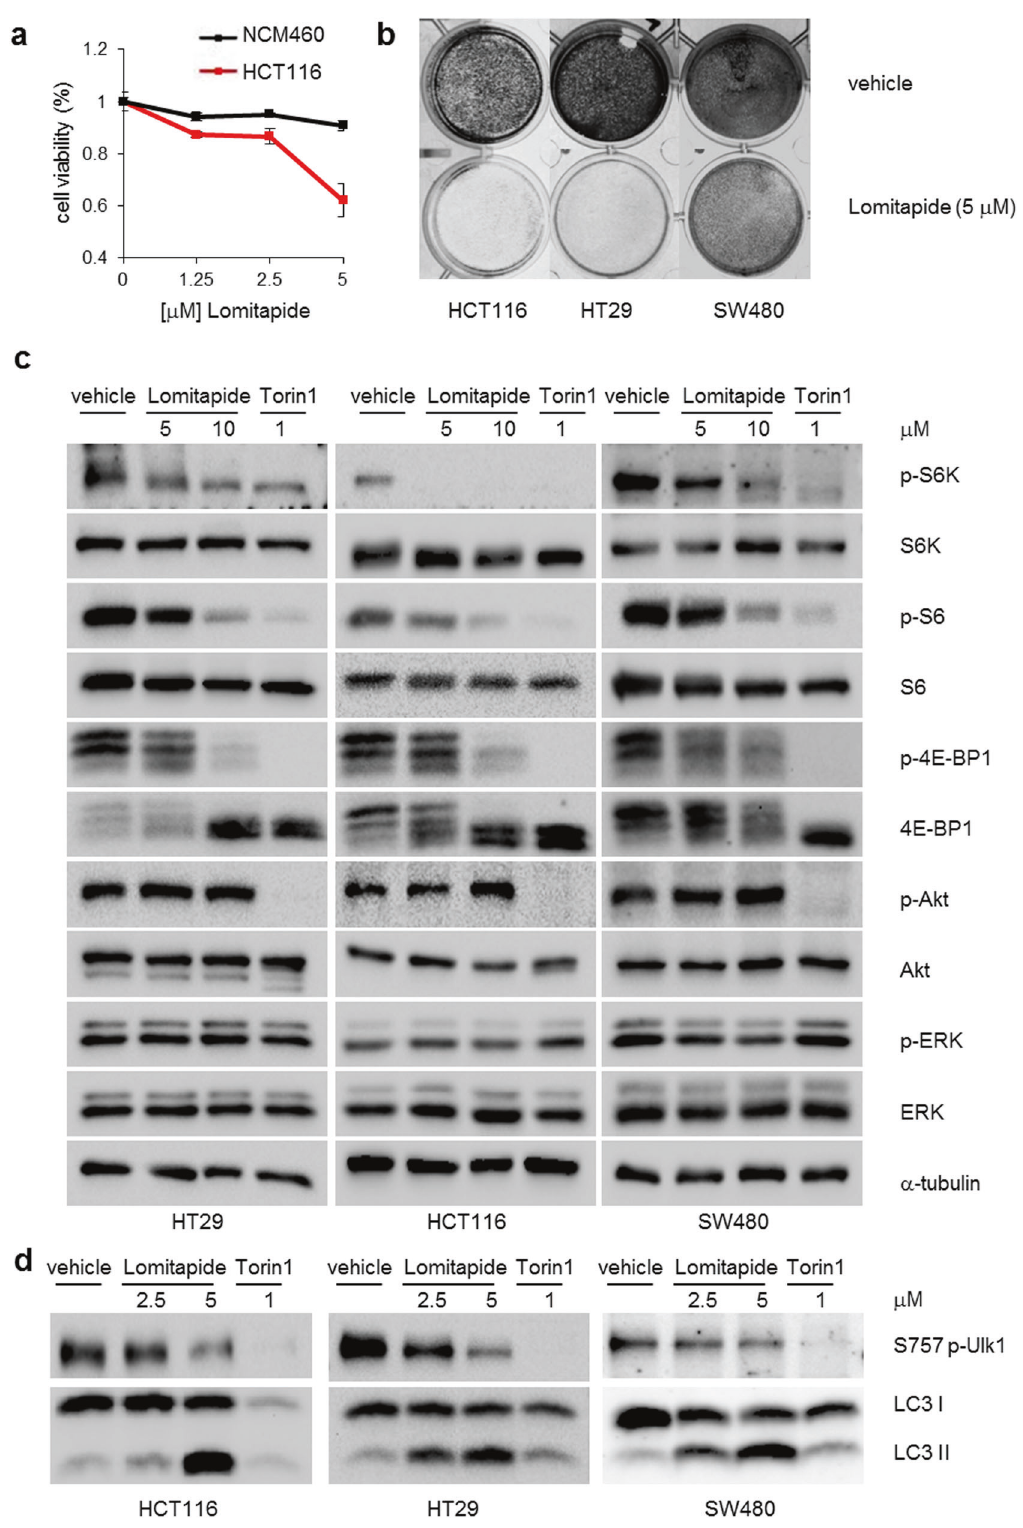
Fig. 2 Lomitapide inhibits cancer cell viability and reduces mTOR signaling. a Cancer-speci fi c growth inhibition of lomitapide on HCT116 colorectal cancer cell line. b Colony formation of vehicle or lomitapide-treated were measured in HT29, HCT116, and SW480 CRC cells. c mTOR downstream signaling defects in CRC cells were analyzed by immunoblotting treated with vehicle or lomitapide for 24 h at the indicated concentration. The mTOR inhibitor Torin1 was used as a control. d S757 phosphorylation of ULK1 and LC3 levels were measured by immunoblotting to assess autophagy